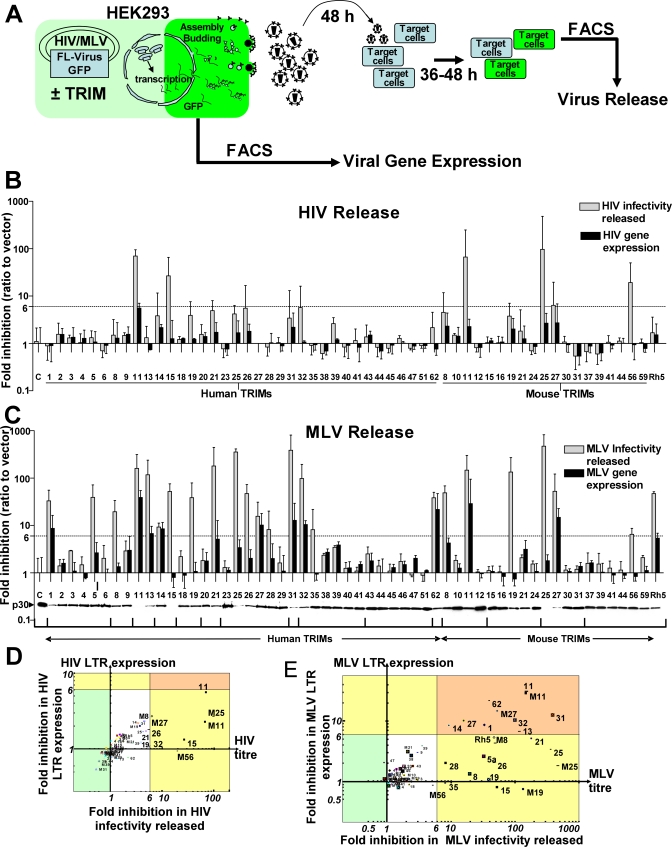
TRIM Proteins Interfering with Virus Production and Release(A) Experimental design: HEK293 cells transfected with viral plasmids encoding full-length HIV or MLV and carrying a GFP-reporter gene in the presence or absence of plasmids encoding individual TRIM proteins. 48 h after transfection, producer cells and culture supernatants were harvested. Producer cells were subjected to FACS analysis to measure viral gene expression. The infectivity of culture supernatants was determined by infecting target cells and measuring GFP-positive cells 36 h after initiation of infection using FACS analysis.(B, C) Effects of TRIM protein expression in HEK293 cells on the production and release of HIV (B) and MLV (C). Graphs represent the fold inhibition (log10 scale) in released viral infectivity (grey bars) and in viral gene expression (black bars). All experiments were performed at least in triplicates and the bars represent standard errors from the mean values. The dotted line represents the statistically determined cut-off value of 6. MLV Gag released into culture supernatant was analysed by western blot using antibodies against p30 MLV capsid and presented beneath the graph in (C). Partition lines indicate individual gels.(D, E) Scatter plots of data shown in panels (B) and (C) depicting fold inhibitions in released virus infectivity plotted against viral gene expression from the LTR upon TRIM expression for HIV (D) and MLV (E).